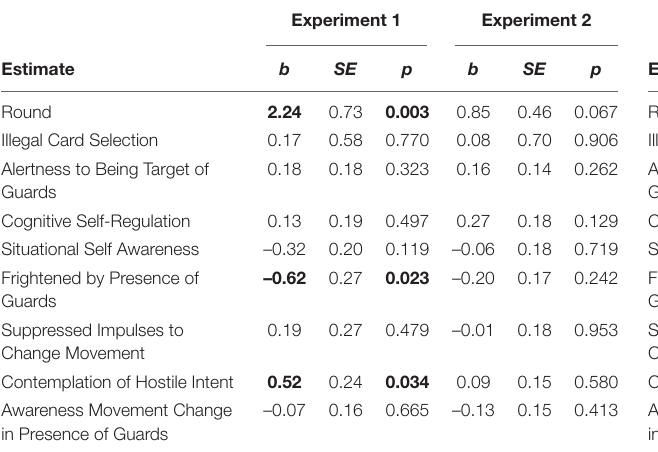
TABLE 5 | Regression beta, SE, and P -values for route deviation as dependent